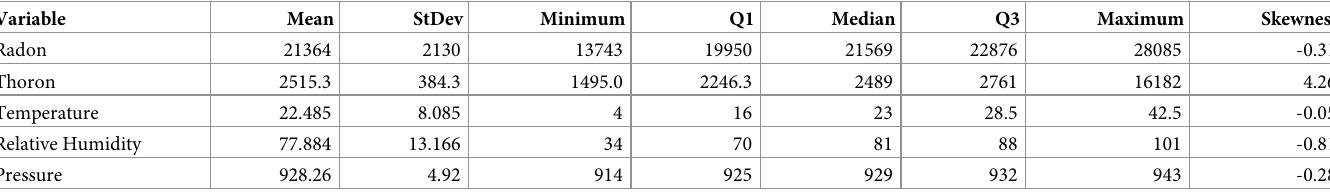
Table 1. Statistical details of the SRGC time series